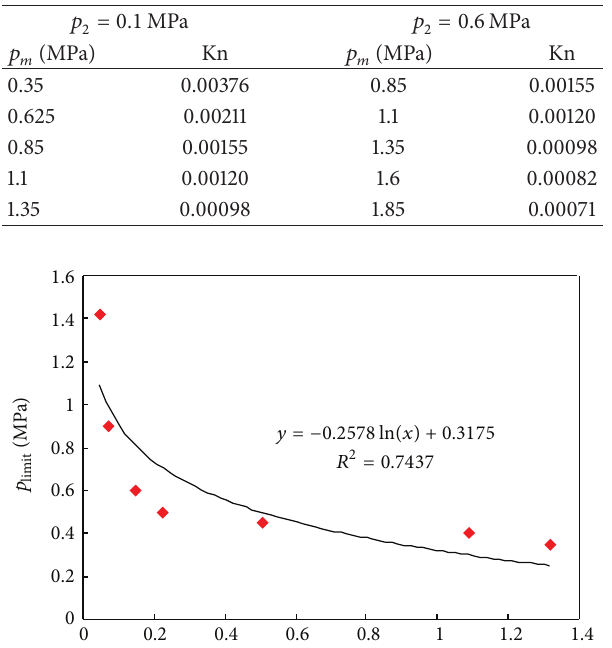
for tight core samples. limit